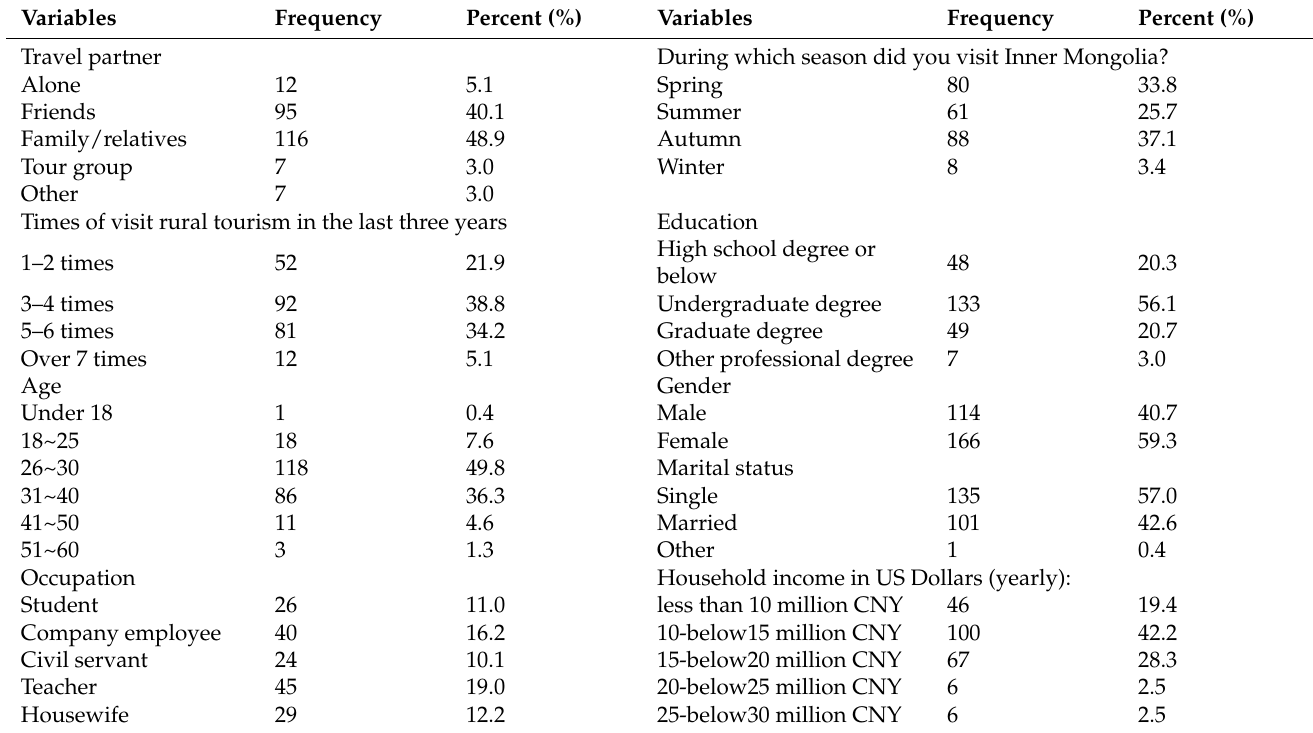
Table 2. Description of the respondents ( n =